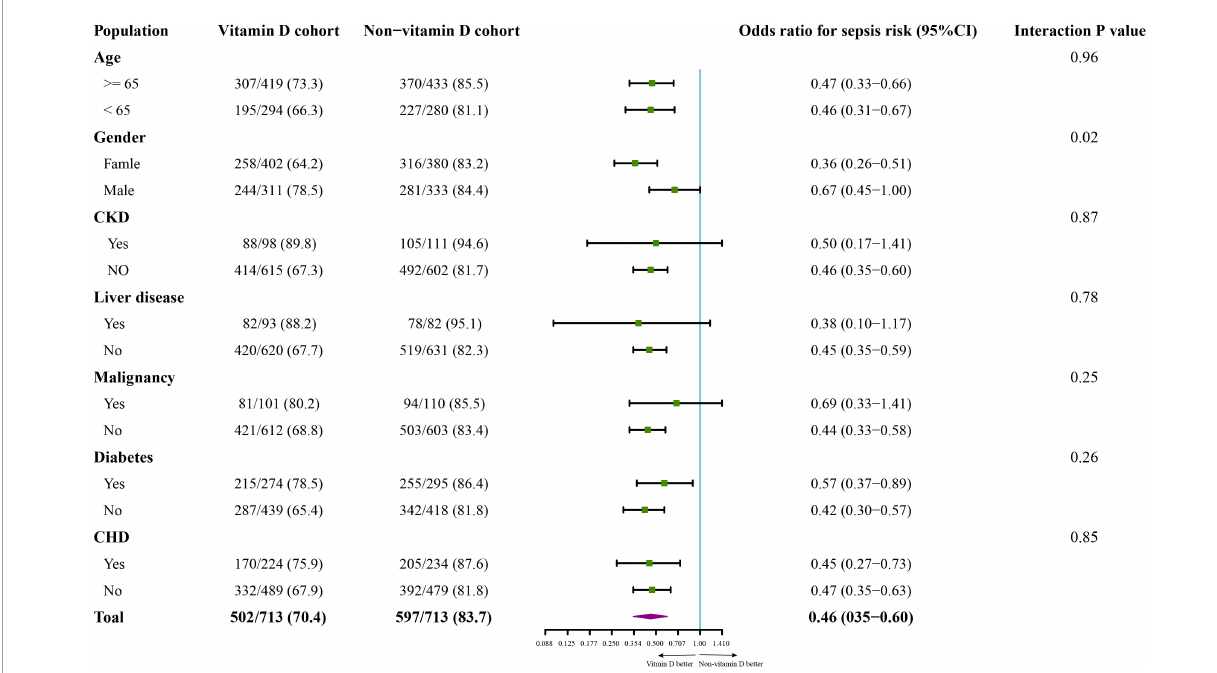
FIGURE3 The subgroup analysis on incidence of sepsis in the propensity score matching cohort. The variables of subgroup analysis, the number of patients with sepsis (numerator), the number of each subgroup population (denominator), the odd ratios for incidence of sepsis, 95% CI in each comparison, and the p -value of interaction between the cohorts (vitamin D cohort or non-vitamin D cohort) and the grouped variables are shown in the forest plot. CKD, chronic kidney disease; CHD, chronic heart